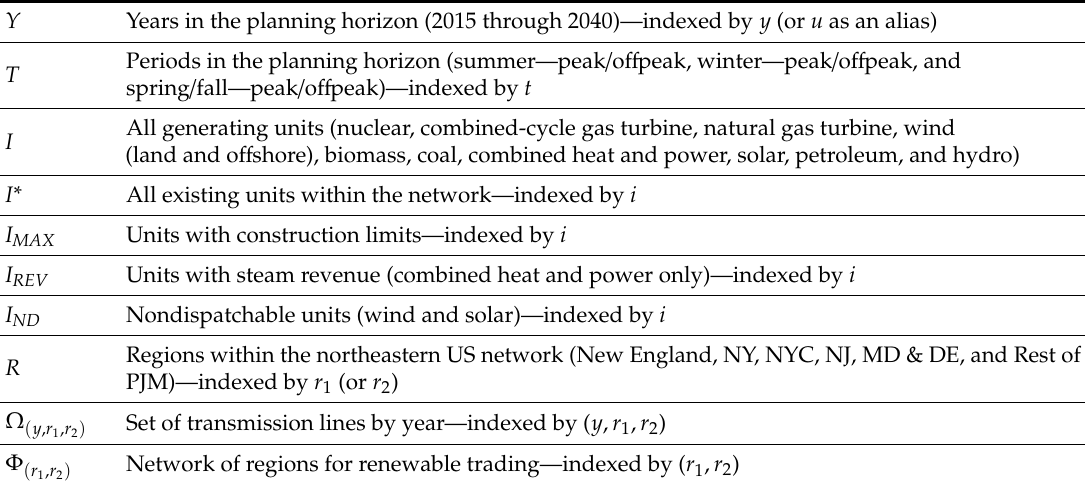
Table 1. GEP Model Set Definitions.